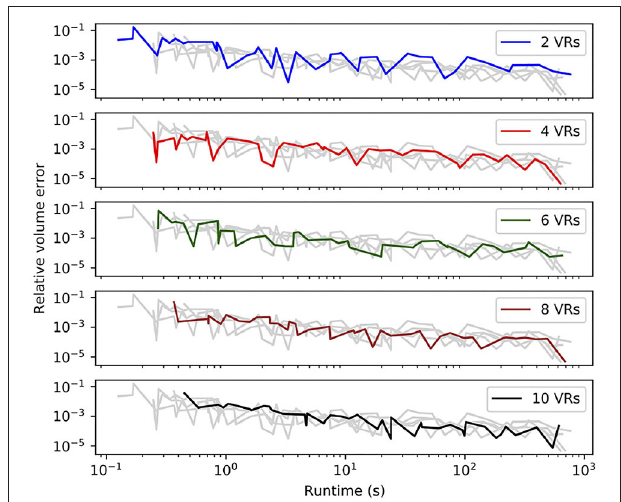
FIGURE 1 | Sub-sampling surface voxels tends to improve the accuracy of the volume estimate for any discretization resolution at the cost of increasing voxelization time. VR is the partial volume resolution, the voxelization times of a cylinder of fixed size and orientation are shown for 50 different values of dx (from 0.01 µ m to 0.5 µ m) and five values of VR (2, 4, 6, 8, 10). Each subplot highlights one of the VRs, with the others shown in grey. As dx decreases, discretization time increases and relative error tends to decrease, but the error is non-monotonic due to changing alignment of the cylinder with the